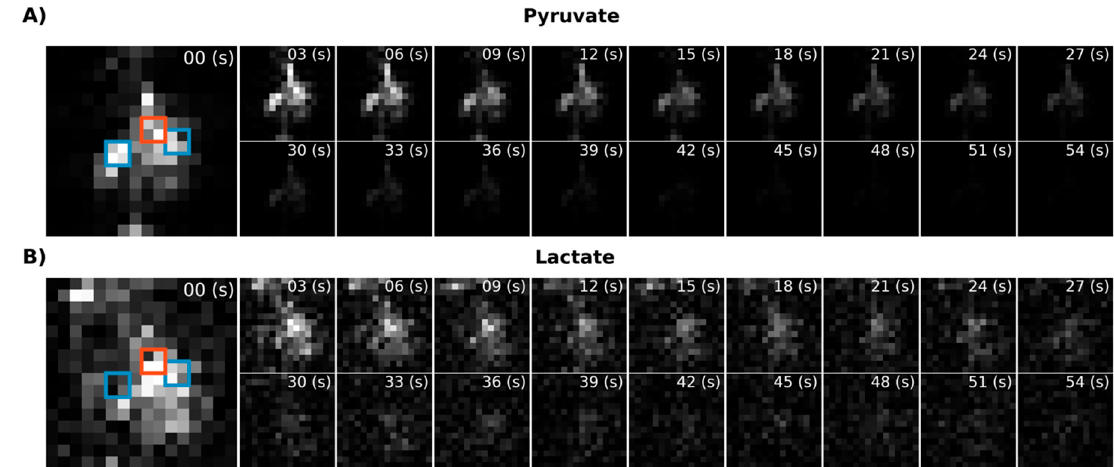
Figure 5. Dynamic metabolic images for [1 ‐ 13 C]pyruvate ( A ) and [1 ‐ 13 C]lactate ( B ) acquired using the metabolite ‐ specific EPI sequence. The blue squares indicate the location of the kidney and the red squares the liver.